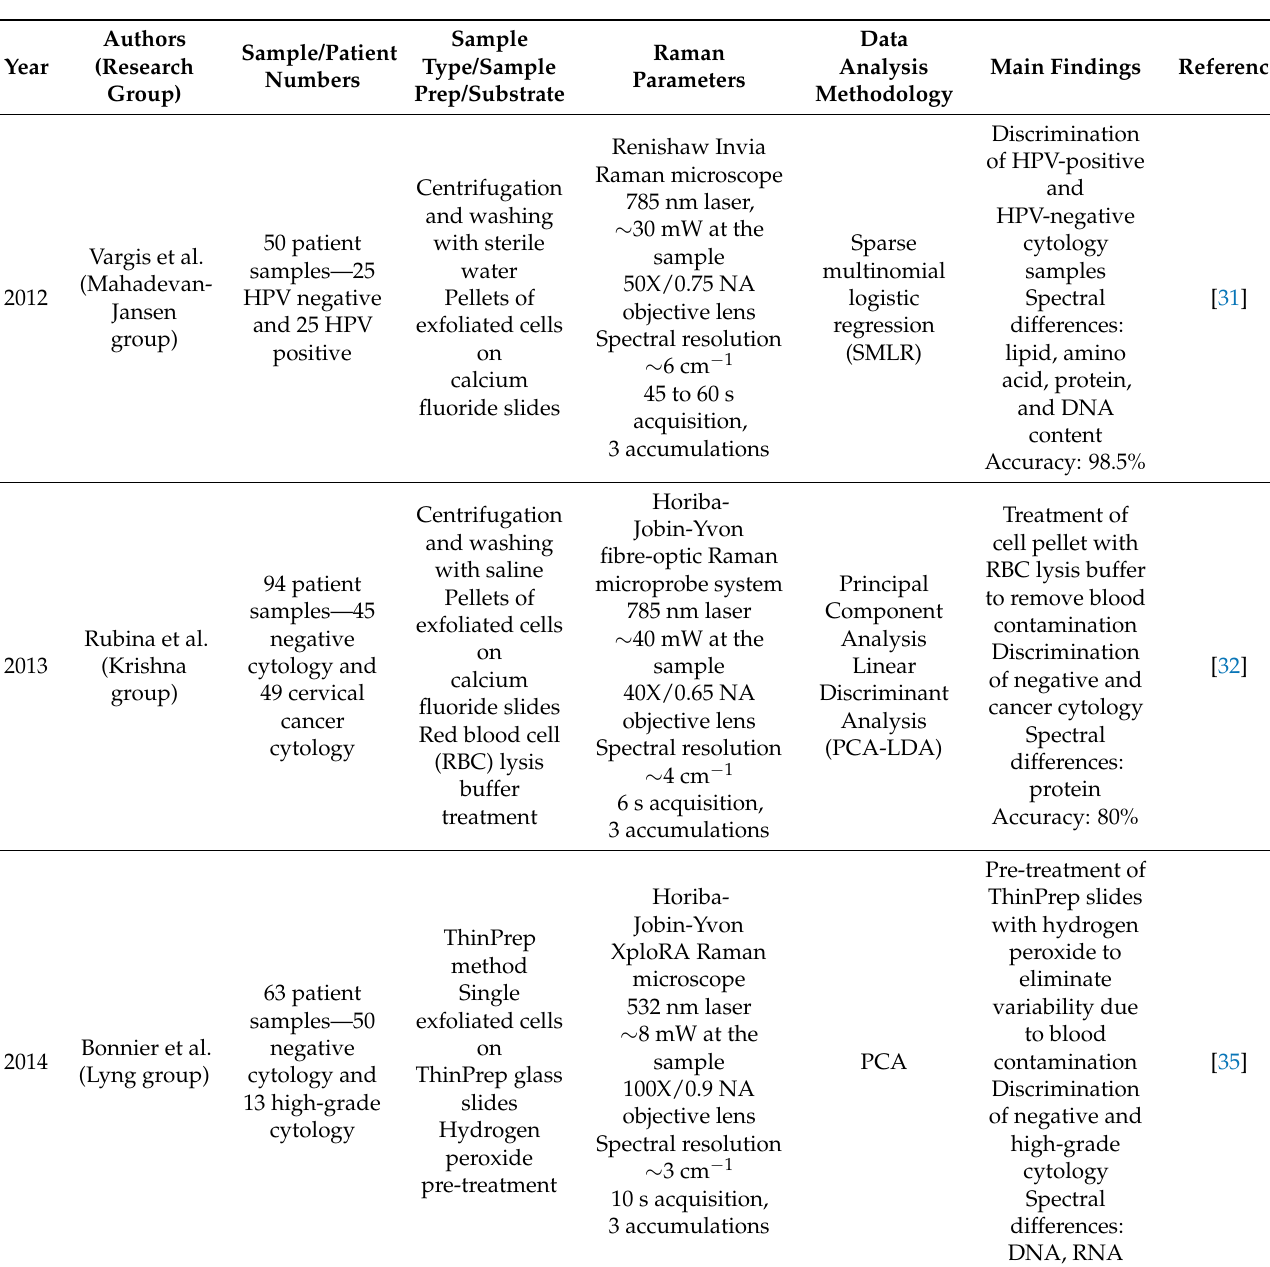
Table 1. Application of Raman spectroscopy in cervical